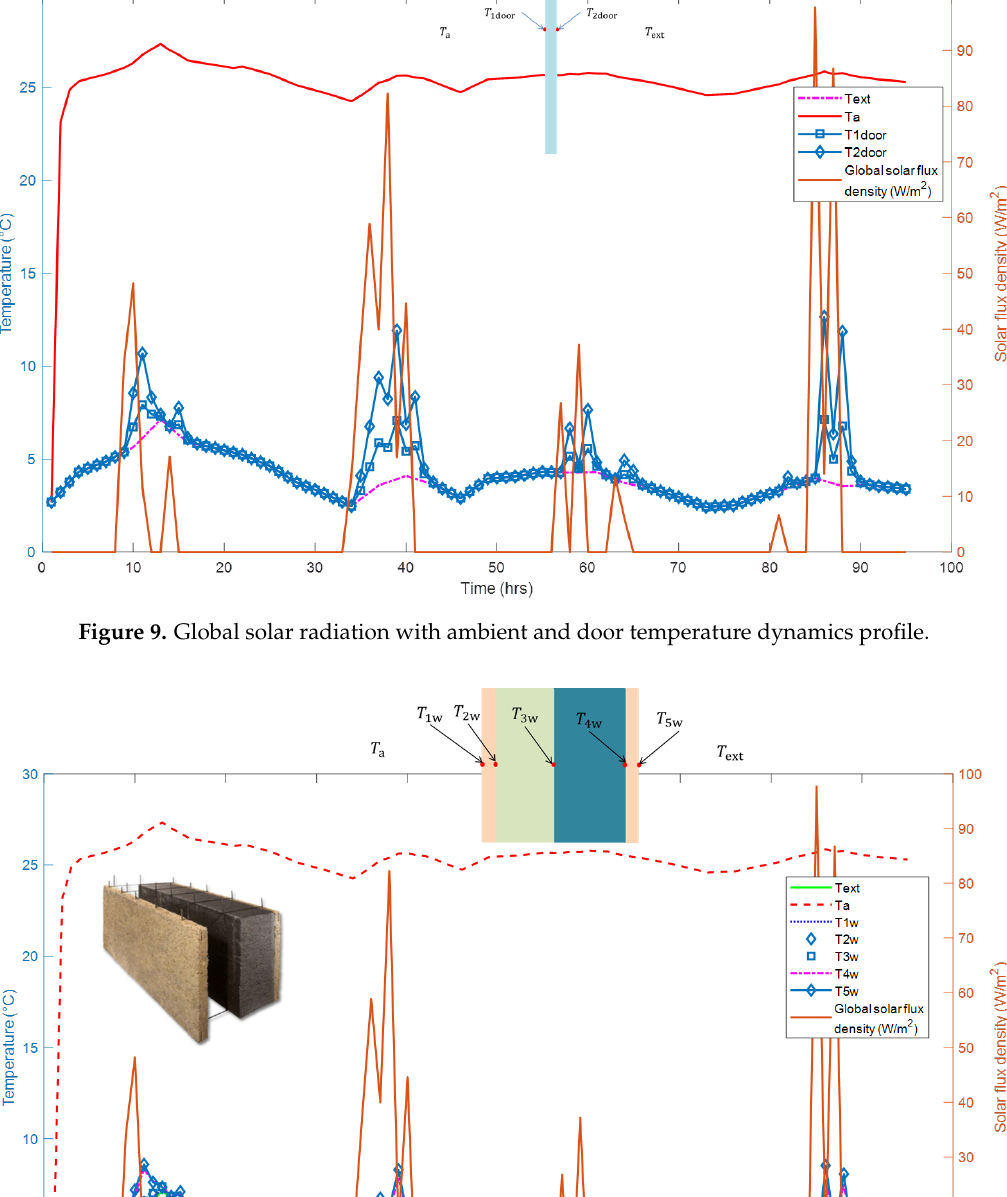
Figure 8. Global solar radiation with internal ambient and floor temperature dynamics profile.